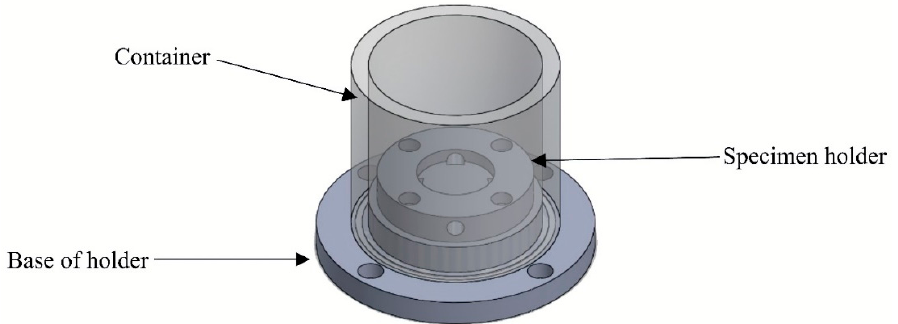
Figure 2. Specimen chamber schematic diagram.